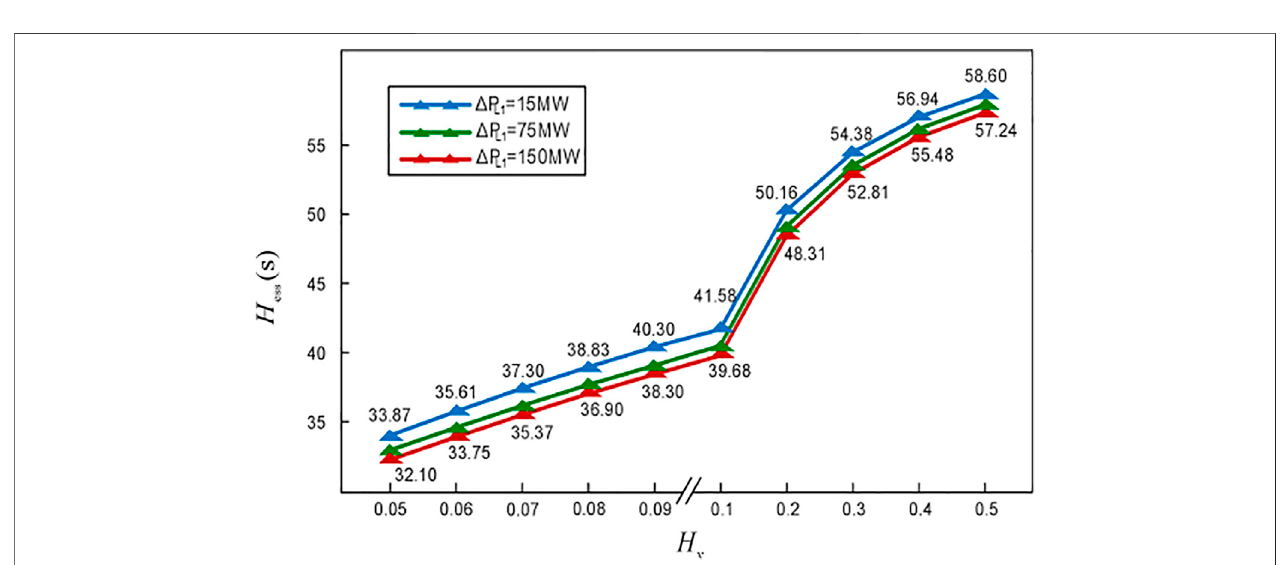
FIGURE 16 | Variations in the H ess with respect to Δ P L1